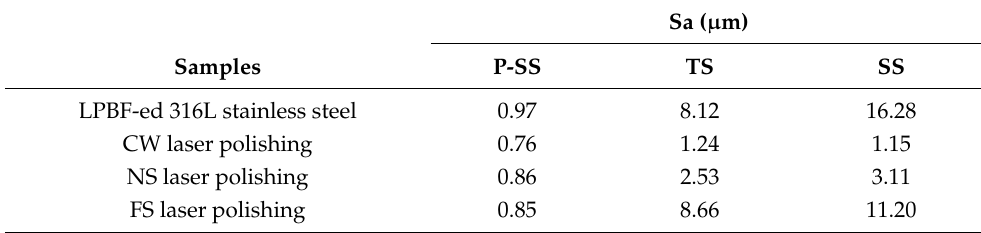
Table 3. Surface roughness of the polished samples with different laser pulse widths.